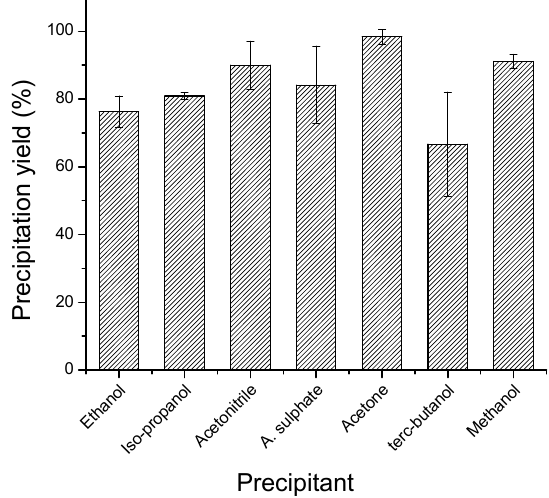
Figure 1. Precipitation of CGTase from Thermoanaerobacter sp. with different precipitants. Precipitation conditions: 1 h reaction, 20°C at 200 rpm stirring, 90% (v/v) precipitant concentration, enzyme solution prepared in 50 mM citrate buffer pH 6.0. Precipitates were recovered by